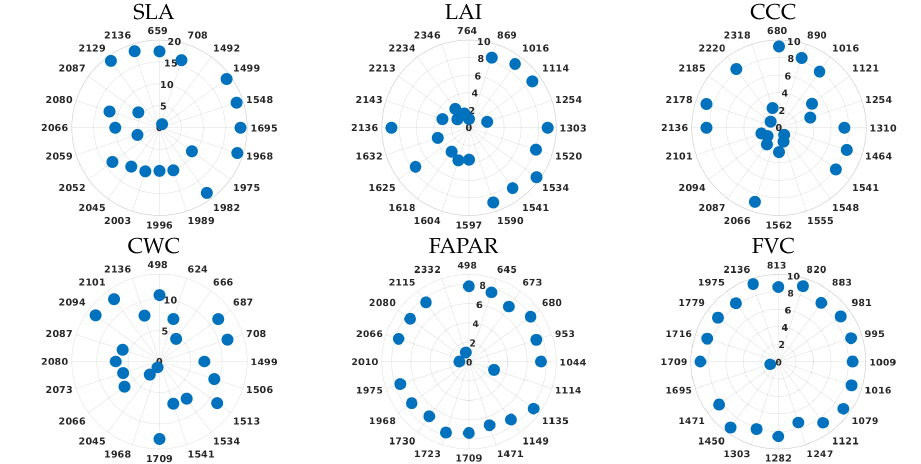
Figure 8. Polar Plots for each variable using the GPR-20BR models. All 20 best-selected bands (in nm) are displayed around the circumference. Distance to origin represents the importance of each band: the more outside, the more